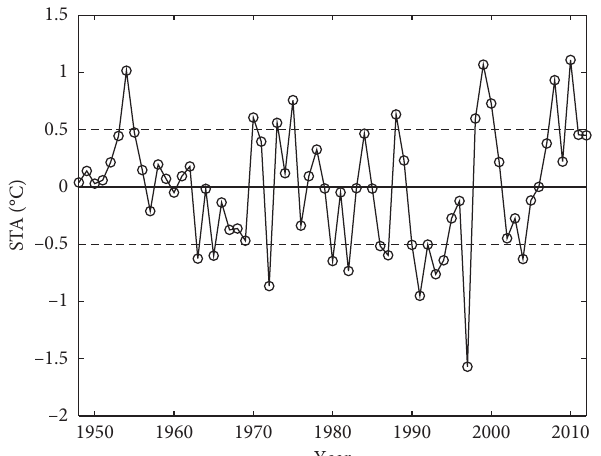
Figure 4: Interannual variations of the detrended subsurface temperature anomalies of the 125m deep layer in the area of 0 ° –30 ° N, 100 ° –180 ° E during JASON season. Table 1: List of the subsurface cold years and warm years during 1948–2012.